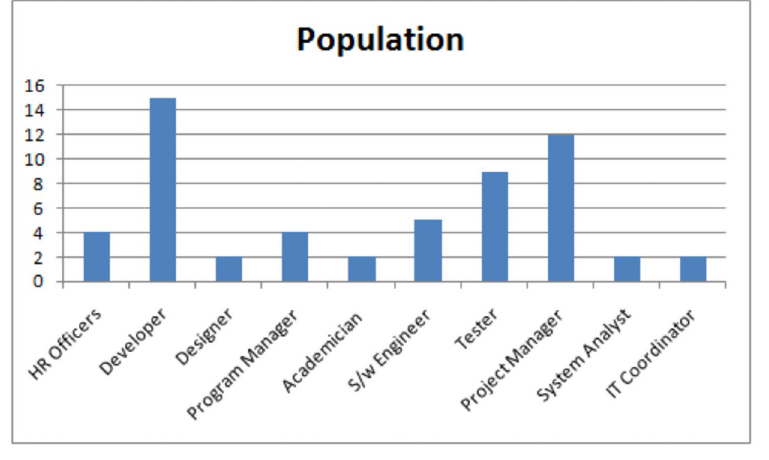
Fig 2. Population of